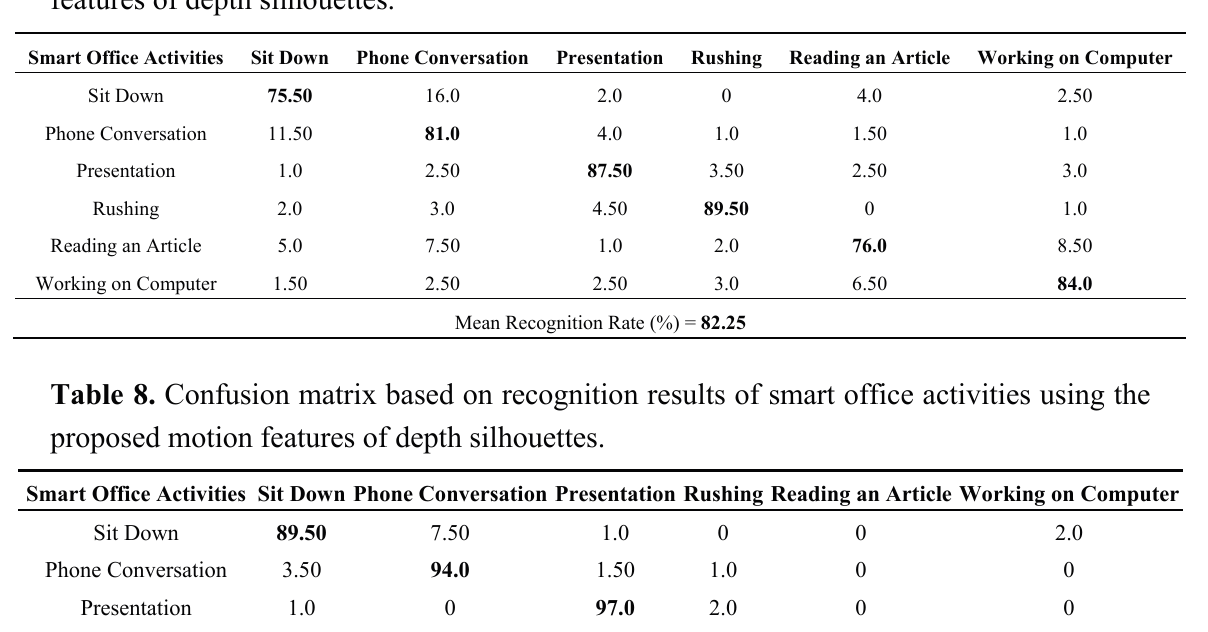
Table 7. Confusion matrix based on recognition results of smart office activities using IC features of depth silhouettes.